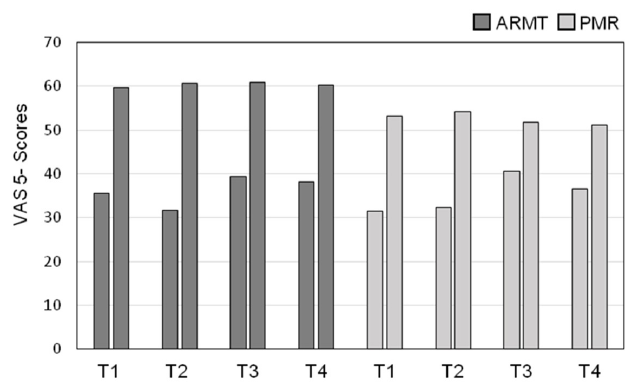
Figure 5. Time course of VAS 5 (psychomotor retardation) scores over time points T 1– T 4 in ARMT vs. PMR groups. Arithmetic means before and after treatment (right and left columns, respectively). Note: A score of 100 signifies that the proband agrees fully with the statement “My body feels light and mobile”.